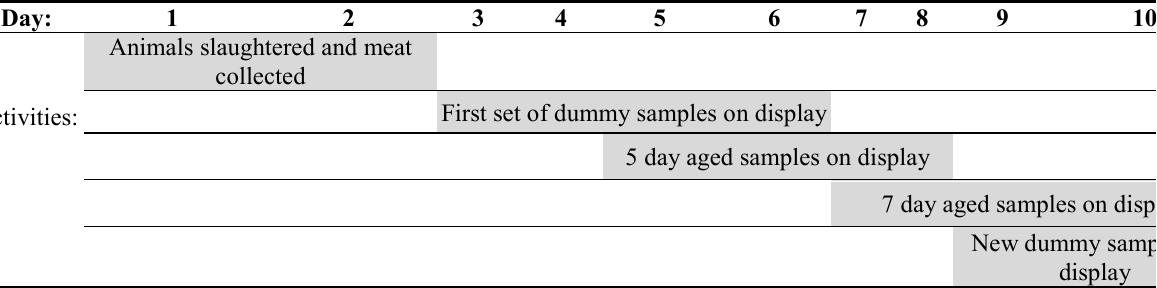
Figure 2. Demonstration of the experimental design for the number of days aged, retail display time, and inclusion of dummy samples within the short storage period.